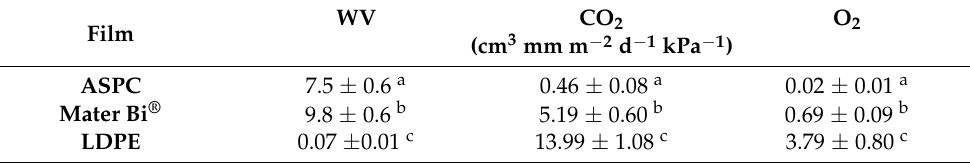
Table 3. Water vapor (WV) and gas (CO 2 and O 2 ) permeability properties of films manufactured with 600 mg of argan seed protein concentrate (ASPC) and 50% glycerol, compared to Mater Bi ® and low density polyethylene (LDPE) films. Different superscript letters (a–c) indicate significant differences among the values reported in each column ( p < 0.05). Further experimental details are given in the